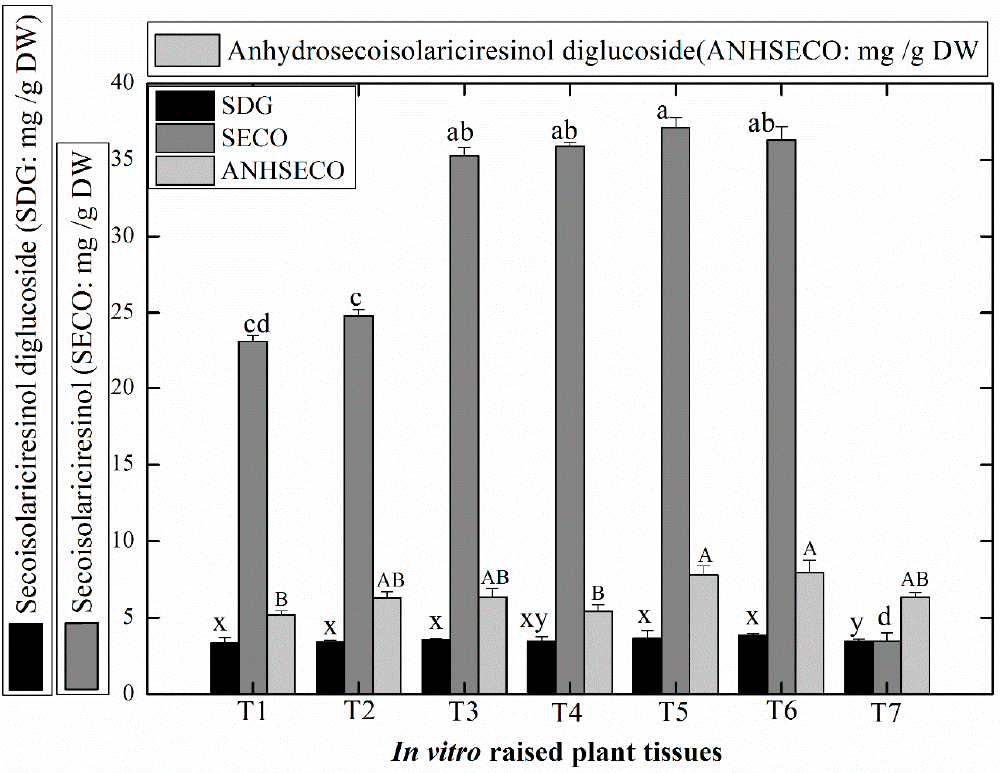
Figure 3. Estimation of the accumulation of bioactive lignans in the micropropagated shoots of L. usitatissimum in response to different PGR treatments. T1: 0.5 mg/L TDZ, T2: 1.0 mg/L TDZ, T3: